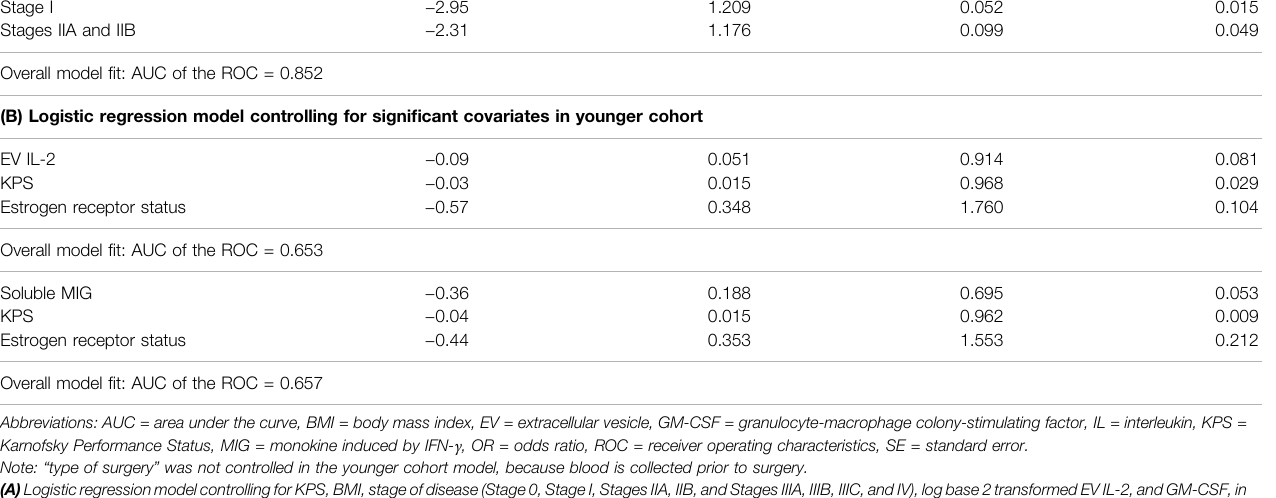
Overall model fi t: AUC of the ROC = 0.828 EV GM-CSF